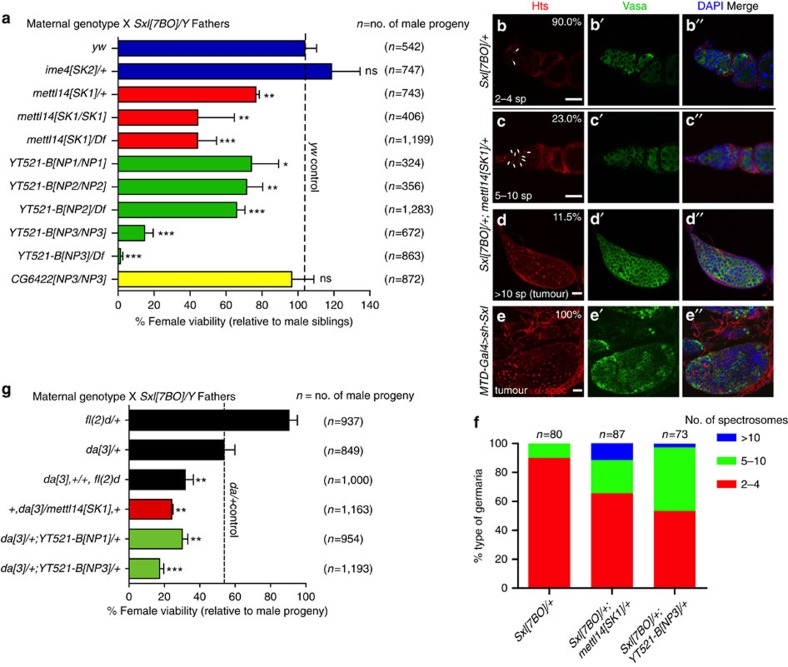
The m6A pathway promotes female sex determination.(a) Genetic interactions of m6A pathway mutants with Sxl. The indicated maternal genotypes were crossed with Sxl null fathers, and the viability of female adults relative to sibling male adults was quantified. mettl14 mutants exhibit substantial loss of female Sxl heterozygotes, while YT521-B mutants, especially of the strong allele YT521-B[NP3], exhibit profound loss of females that lack a copy of Sxl. (b–e) Germaria regions of ovarioles stained for spectrosome markers in red (Hts, (b–d) or alpha-spectrin, e), germline marker in green (Vasa, b′–e′), merged panels with DAPI (b″–e″). Scale bars, 20 μm. (b) Nearly all Sxl/+ ovarioles exhibit the normal 2–4 spectrosomes (sp, marked by white lines). (c) Nearly one fourth of Sxl/+; mettl14/+ ovarioles exhibit 5–10 spectrosomes, while >11% exhibit ovarioles full of undifferentiated germline stem cell-like tumours (d). (e) The latter resemble tumorous ovaries that result from germline knockdown of Sxl, although these are obtained with full penetrance. (f) Quantification of supernumerary spectrosome phenotypes in Sxl dominant interaction tests with m6A mutants. (g) Genetic interactions of m6A pathway mutants with Sxl and da. Daughterless (da) exhibits haploinsufficiency in Sxl/+ females, and thus serves as a genetically sensitized background. Thus, loss of one allele of fl(2)d has little effect on Sxl/+, but concomitant heterozygosity of da and fl(2)d enhances female lethality of Sxl/+. Similarly, in the da sensitized background, heterozygosity for mettl14 and different YT521-B alleles all dominantly enhance female loss in Sxl/+.